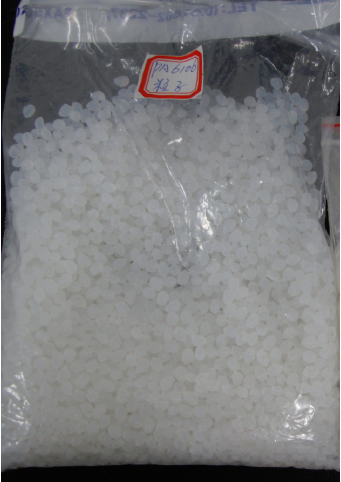
Figure 1. Image of hot-melt polyamide